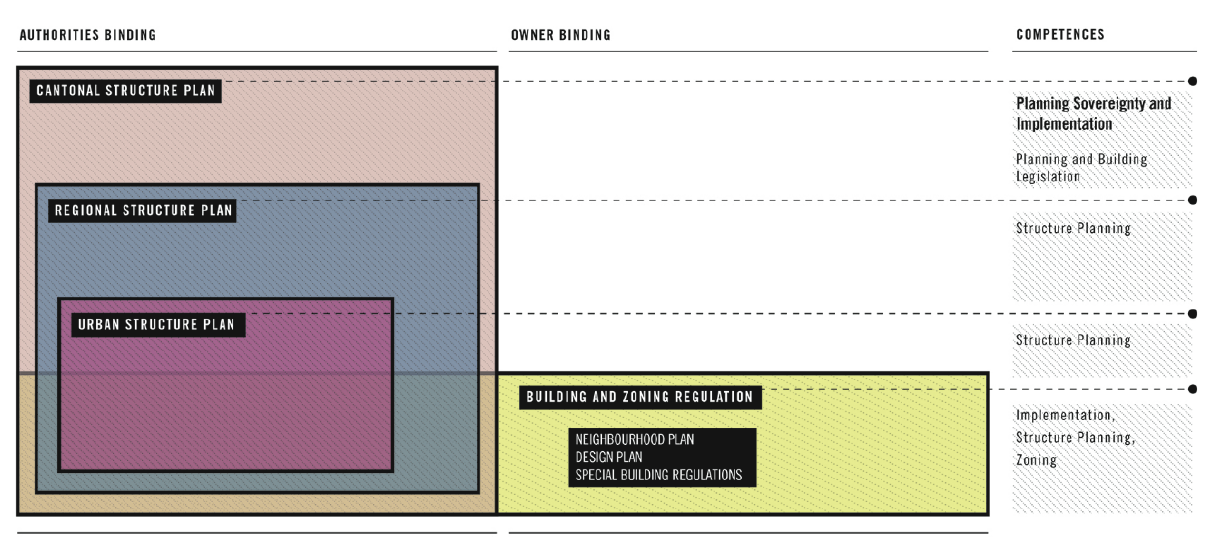
Figure 3. Competences and bindings of different planning instruments on cantonal, regional and local level for the Canton of Zürich. Source: author based on Hoelzel,